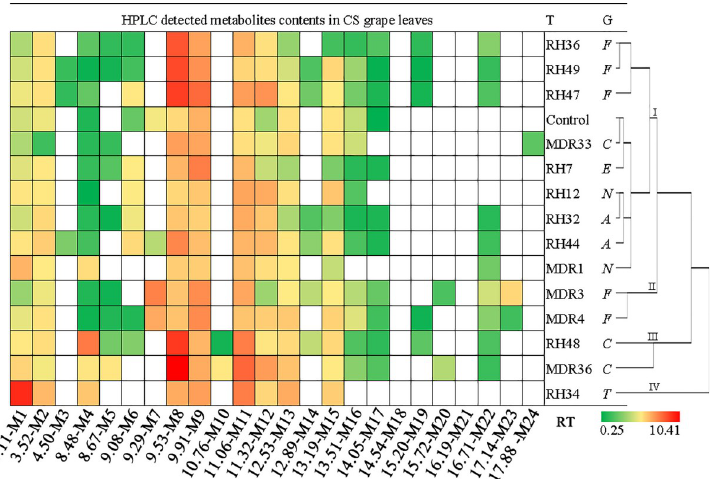
Fig 3. Heatmap and clustering of HPLC-detected metabolite contents in CS grape leaves. T: treatment (represented as endophytic fungal strain ID and the control). HPLC-detected compounds are marked as colored bricks, and different colors represent the content of the metabolites. G: genus of the endophytic fungal strains, C : Colletotrichum; E : Epicoccum; A : Alternaria; F : Fusarium; T : Trichothecium; N : Nigrospora . RT: the retention time that the metabolites appeared in HPLC assay.